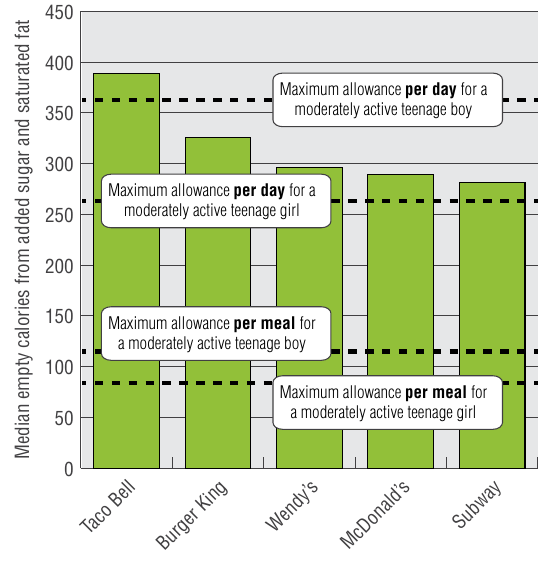
Figure 20. Empty calories in a regular menu